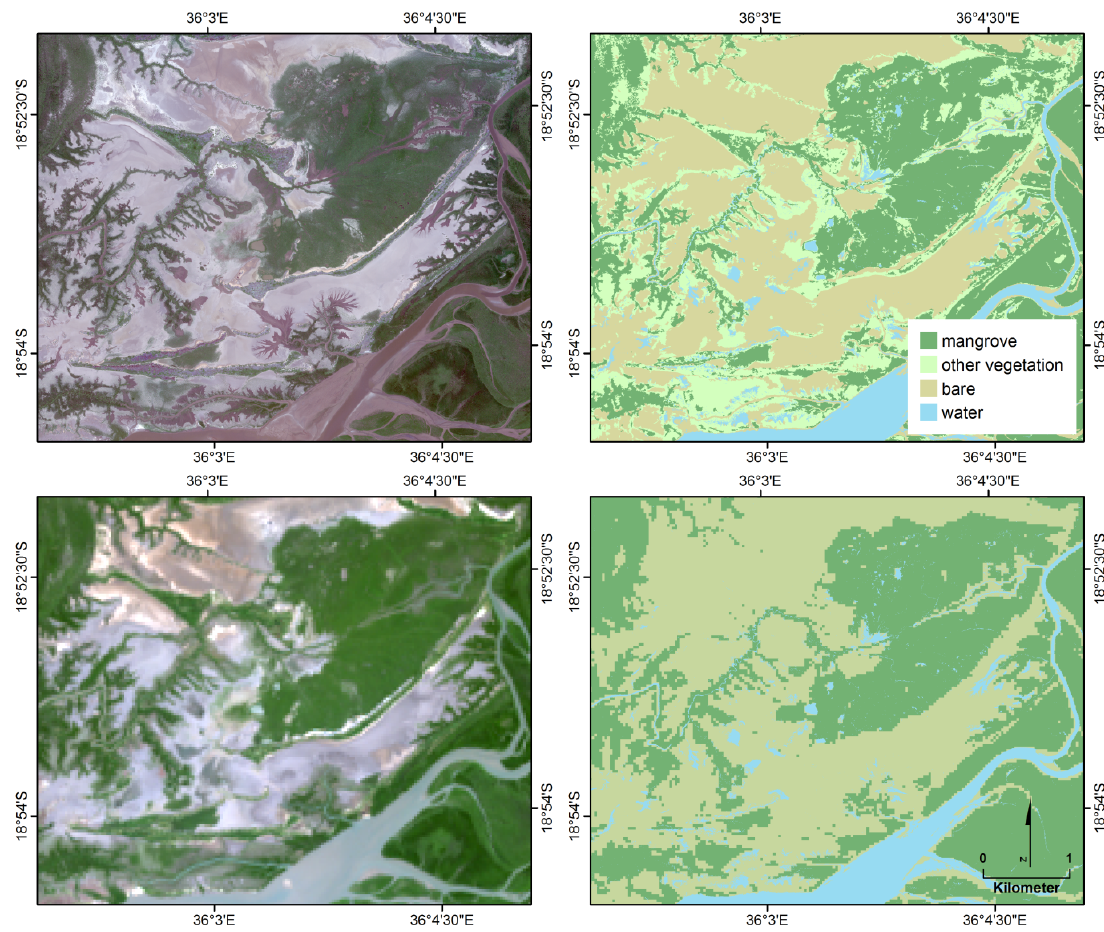
Figure 5. Comparison of mangrove mapping in 2013 with high resolution WorldView-2 ( top row ) and Landsat ( bottom row ) data within the Zambezi River Delta; the satellite image is shown on the left and the classified data on the